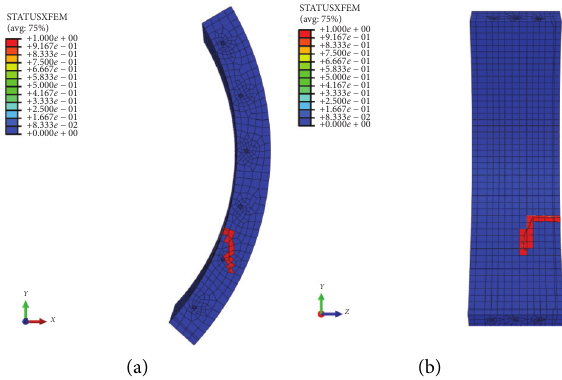
Figure 7: The final crack in the shield tunnel segment.